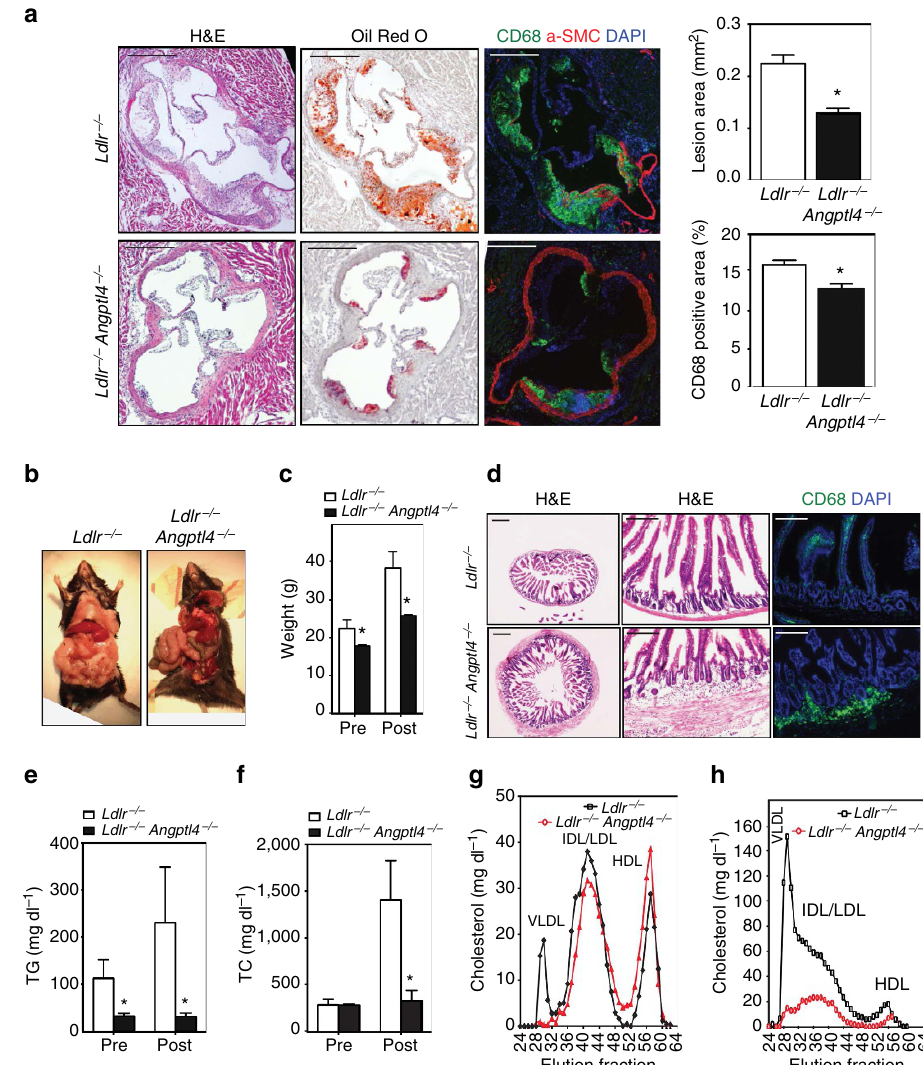
Figure 2 | Absence of ANGPTL4 attenuates the progression of atherosclerosis. ( a ) Representative histological analysis of cross-sections of the aortic sinus from Ldlr (cid:2) / (cid:2) and Angptl4 (cid:2) / (cid:2) Ldlr (cid:2) / (cid:2) mice stained with H&E, Oil Red O and CD68/SMC-actin/DAPI. Quantification of the lesion area and macrophage content is shown in the right panels ( n ¼ 9 per group). Scale bars, 400 m m. ( b ) Representative pictures of whole body Ldlr (cid:2) / (cid:2) and Angptl4 (cid:2) / (cid:2) Ldlr (cid:2) / (cid:2) mice on WD diet 12 weeks. ( c ) Body weight analysis of Ldlr (cid:2) / (cid:2) and Angptl4 (cid:2) / (cid:2) Ldlr (cid:2) / (cid:2) mice before and after WD diet ( n ¼ 9 per group). ( d ) Representative histological analyses of cross-section of the ileum from Ldlr (cid:2) / (cid:2) and Angptl4 (cid:2) / (cid:2) Ldlr (cid:2) / (cid:2) mice stained with H&E and macrophage marker CD68. Scale bars, 400 m m. ( e – h ) Measurement of plasma TG ( e ), cholesterol ( f ) and lipoprotein profile from pooled plasma ( g - h ) of Ldlr (cid:2) / (cid:2) and Angptl4 (cid:2) / (cid:2) Ldlr (cid:2) / (cid:2) mice before and after 12 weeks on WD diet ( n ¼ 9 per group). All data are the mean ± s.e.m.; * P o 0.05 by comparison with data from Ldlr (cid:2) / (cid:2) mice by unpaired t BM from WT and Angptl4 (cid:2) / (cid:2) mice, we profiled the myeloid population in the peripheral blood before and after feeding a WD.